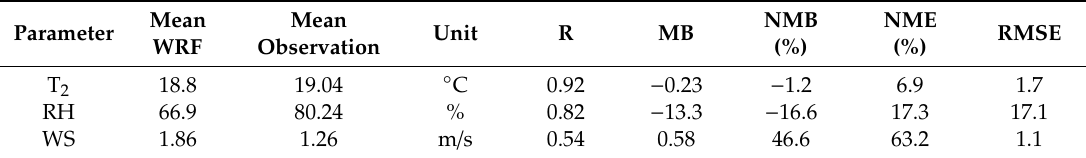
Figure 6. Comparison of ( a ) temperature, ( b ) relative humidity (solid lines) and water mixing ratio (dotted lines), ( c ) wind speed and ( d ) wind direction at NVC station. The magnitude of each vector represents the wind speed. Table 2. Statistical parameters for T 2 , RH, and WS in December 2010